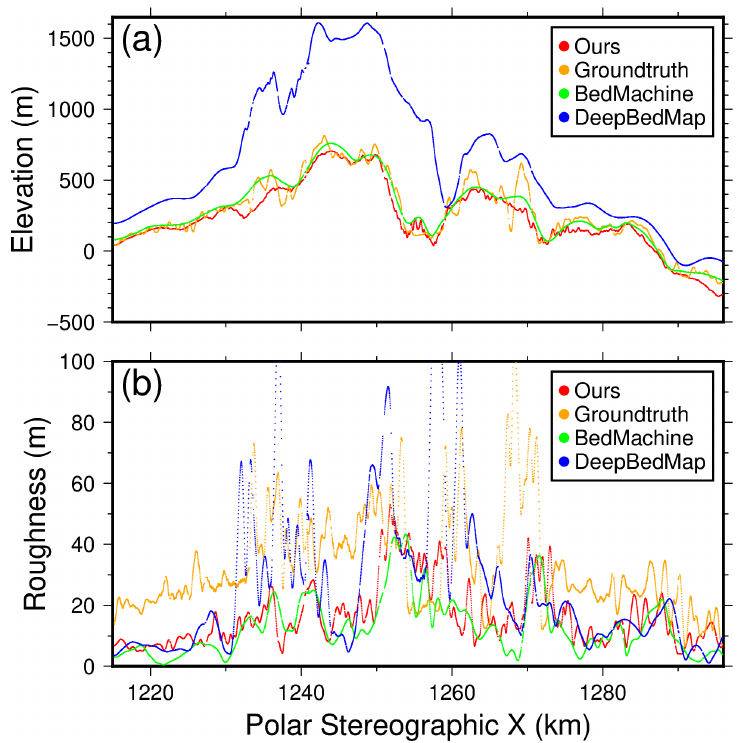
Figure 12. Comparison bed elevation ( a ) and bed roughness ( b ) of each grid product over a transect in Dome C (see Figure 11c, orange line).